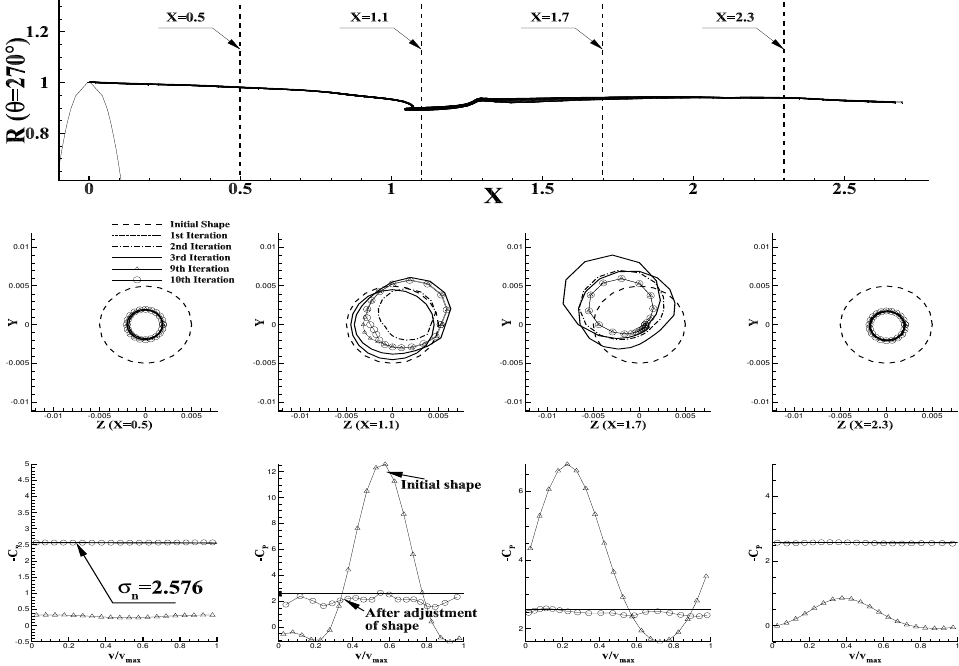
Figure 23. Projected view of the developed tip vortex cavitation from the BEM at blade angle θ = 270 ◦ on X − R plane ( up ). Convergence history of the cavitation sections at the denoted downstream locations ( middle ). Pressure distributions on the tip cavity surface at the same locations from the initial and the converged shape ( bottom